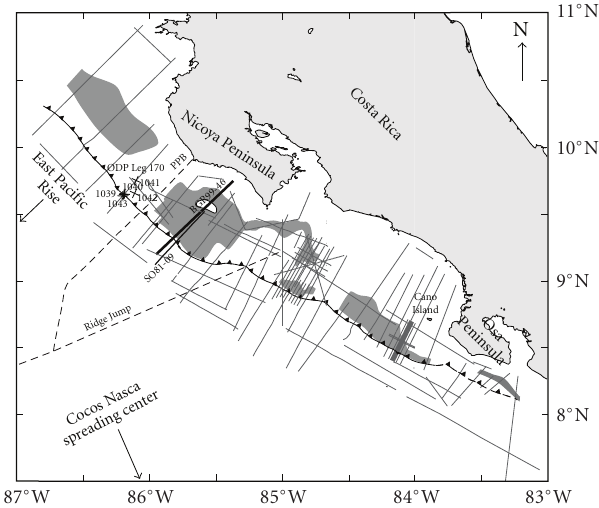
Figure 1: The reflection seismic profiles (light grey lines) o ff shore western Costa Rica were acquired during cruises BGR99 and SO81. The crosses mark the drill sites of ODP Leg 170 north-west of the Paleo Plate Boundary (PPB). The PPB refers to the boundary of the Cocos Plate’s two distinct origins, the East Pacific Rise, and the Cocos Nasca spreading centre. The Ridge Jump is characterized by a seamount chain [32]. The thick black line is profile BGR99- 46, which is discussed in this work and is located o ff shore Nicoya Peninsula. The figure is modified from M¨uller et al. [13] who interpreted the BSR occurrence (dark grey shaded area) along the continental margin from onboard processed data.